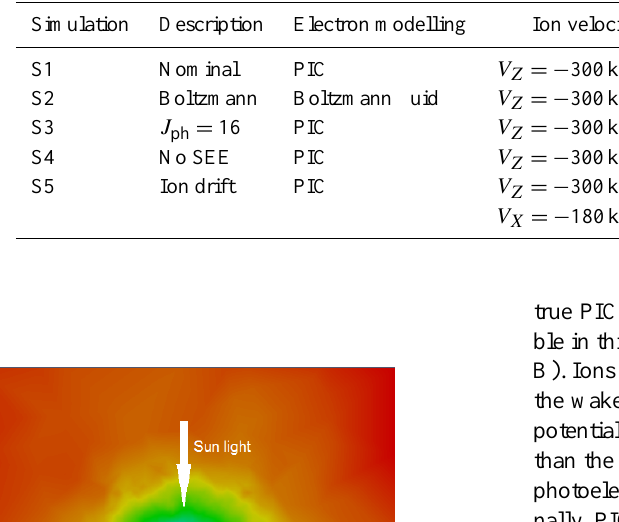
Fig. 11. Plot along the z-axis of the plasma potential for all SPIS simulations (parametric study). Table 4. Specific inputs for the parametric study.